Question: Name the type of graph shown.
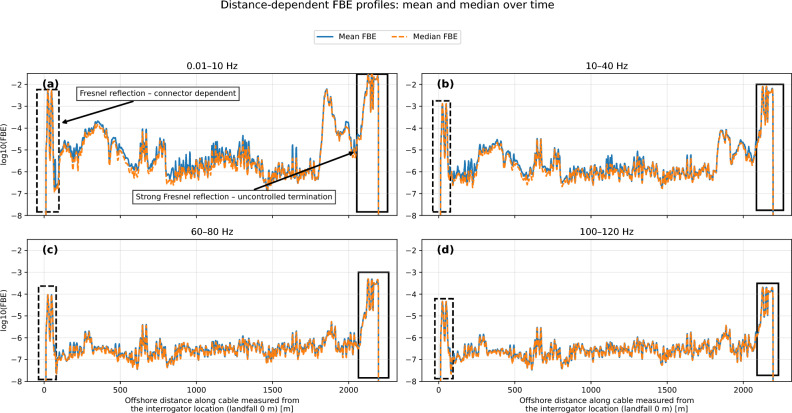
Answer: line